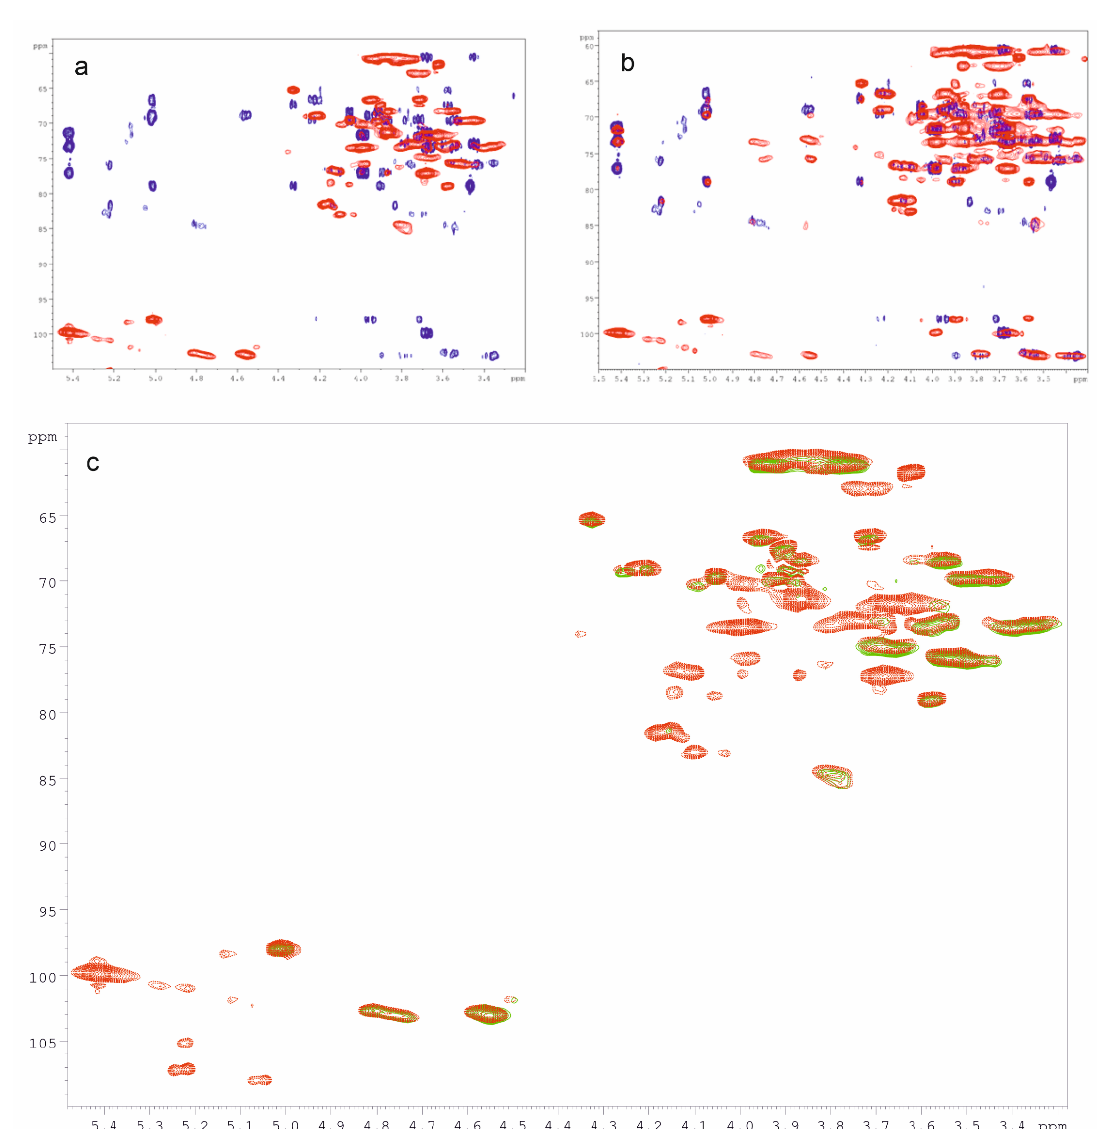
Figure 3. ( a ) HMBC (blue) and HSQC (red) NMR spectra of IPSsb0–2.5 2%; ( b ) HMBC (blue) and HSQC-TOCSY (red) NMR spectra of IPSsb0–2.5 2%; ( c ) HSQC spectra of IPSsb0–2.5 2% (red) and of F-Chaga HW (green). NMR spectra were recorded in D 2 O at 308 K. See Table 2 for signal assignments. Table 2. 13 C and 1 H chemical shifts (ppm) for the polysaccharides extracted from I. obliquus mycelium. Type of linkage